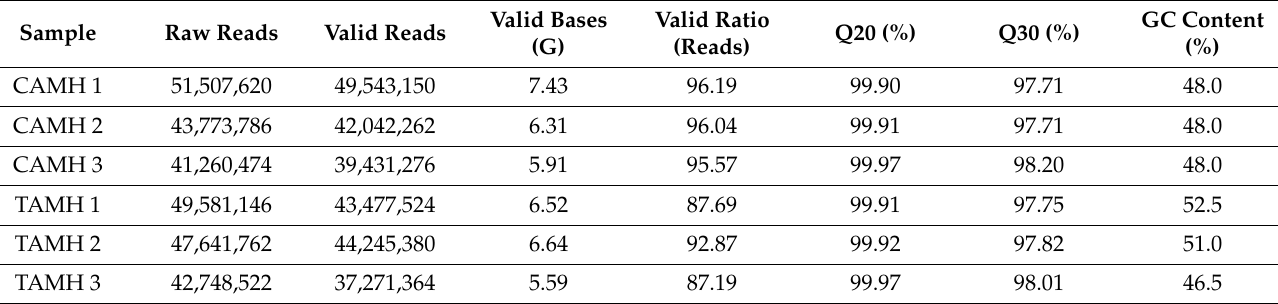
Table 3. Overview of RNA-sequencing data and quality filtering.